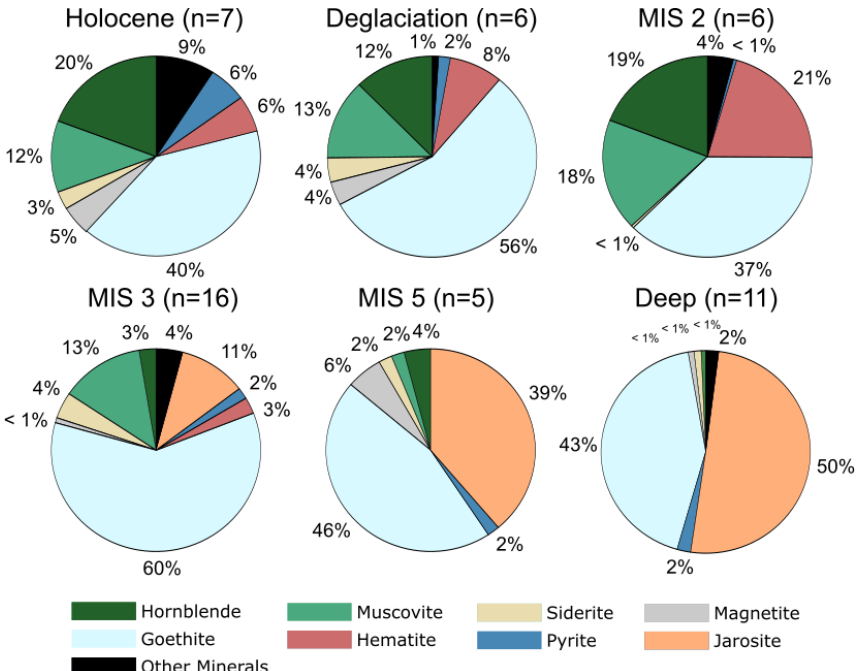
Figure 5. Pie charts showing the Fe mineralogy of TALDICE dust. Each chart refers to a climatic period. Marine isotope stages 4 and 6 have been excluded because of the low number of samples corresponding to these periods.